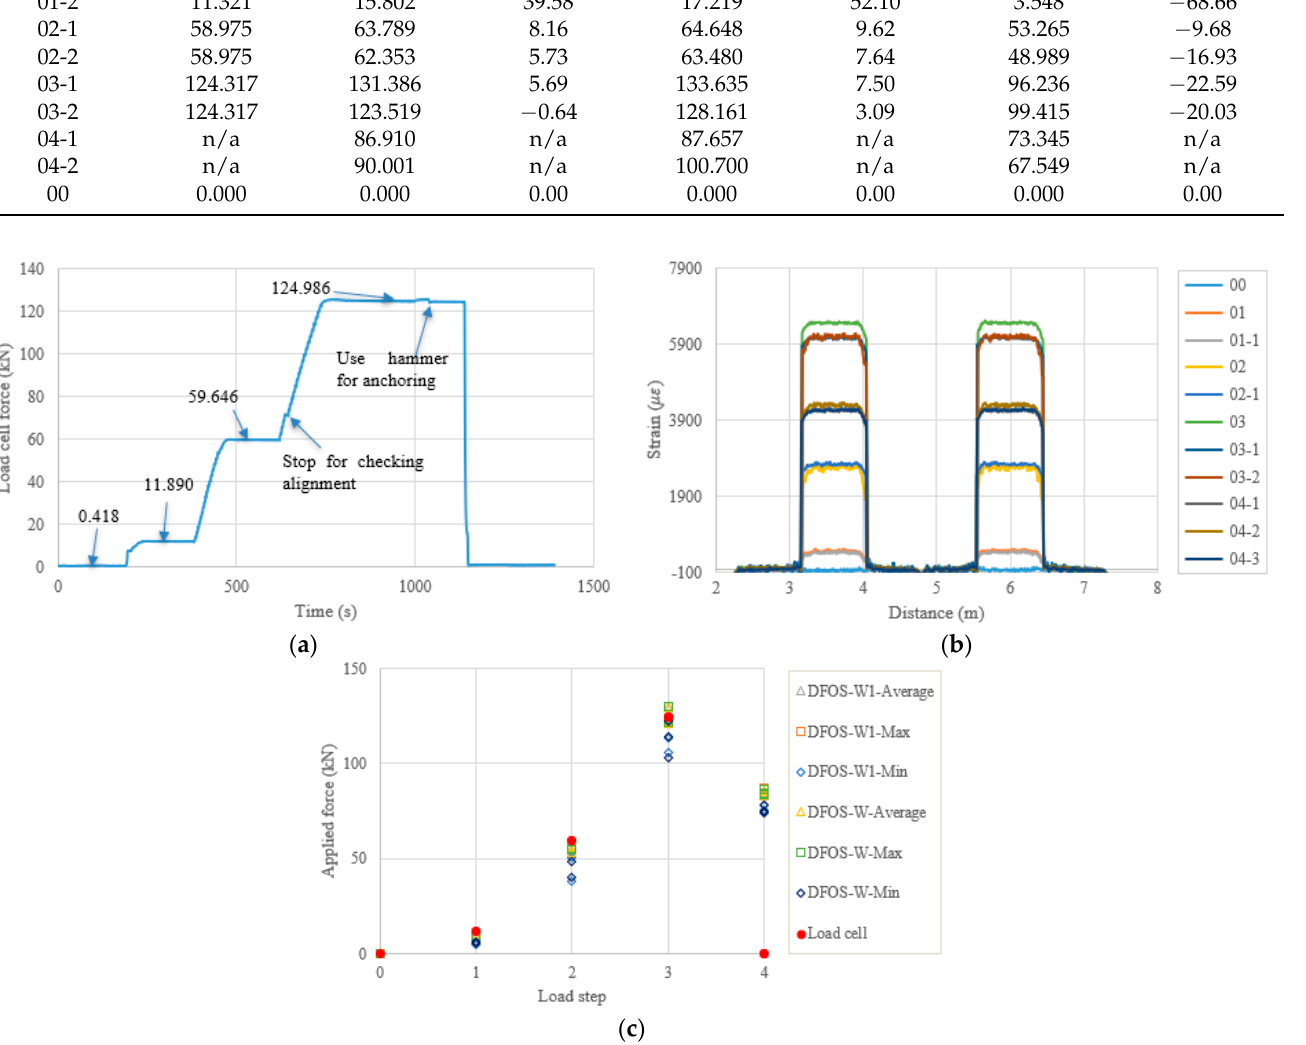
Figure 9. ( a ) Load cell readings for PC6; ( b ) strain distribution along the strand (W1 and W fibers) (In the legend, the first number represents the load step, and the second number represents measurement times at the load step); and ( c ) applied force changes at different load steps. Table 6. Prestressing force monitored by load cell and DFOSs for PC6 (unit: kN).